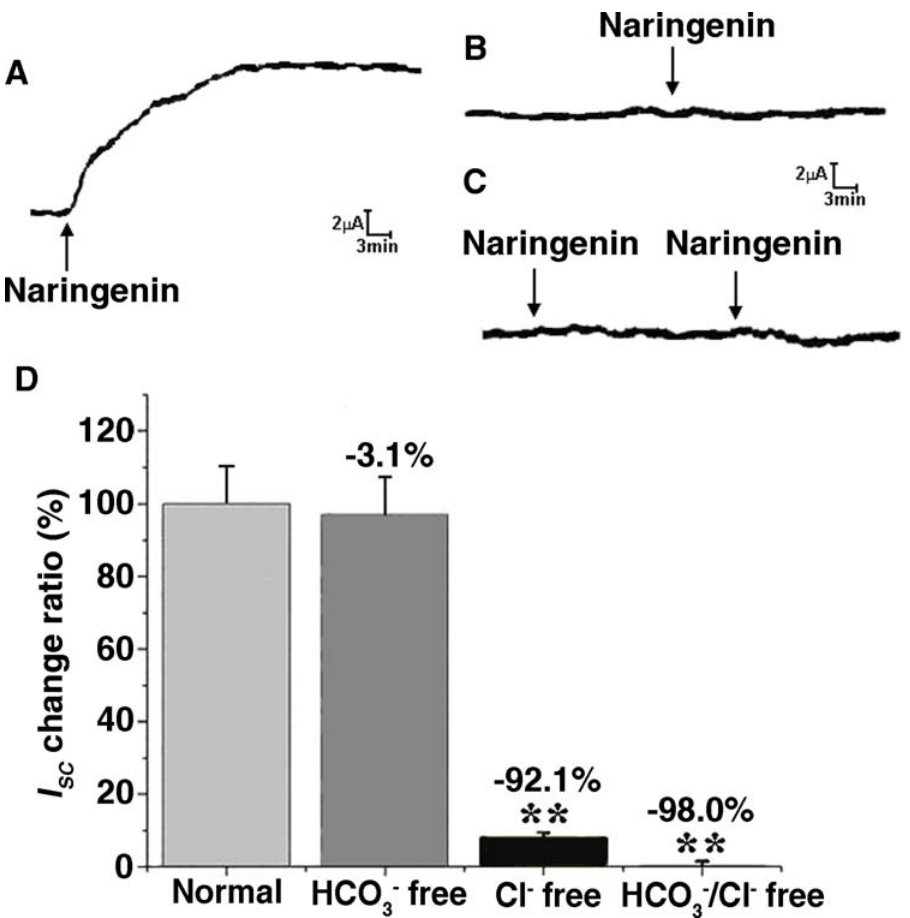
Figure 2. Ionic basis of NAR-evoked Isc . Representative I SC recording with arrows indicating NAR (100 m M) added basolaterally,. Values are mean 6 SE; ** P , 0.001. (A) HCO 3 2 -free K-HS; (B) Cl-free K-HS; (C) Cl 2 /HCO 3 2 -free K-HS; (D) Comparison of NAR-induced total charges transferred in normal, HCO 3 2 -free K-HS, Cl 2 free K-HS and Cl 2 /HCO 3 2 -free K-HS.